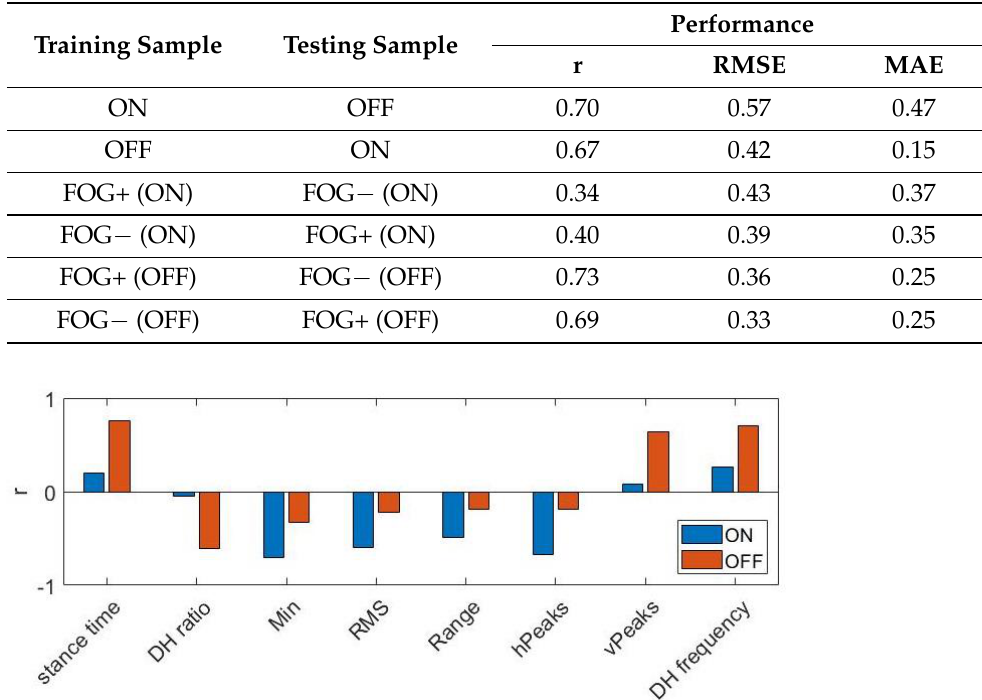
Table 12. Performance of the regression model for different combination of training and test samples. ON: under dopaminergic therapy; OFF: not under dopaminergic therapy; FOG+: patients with freezing of gait; FOG − : patients without freezing of gait.